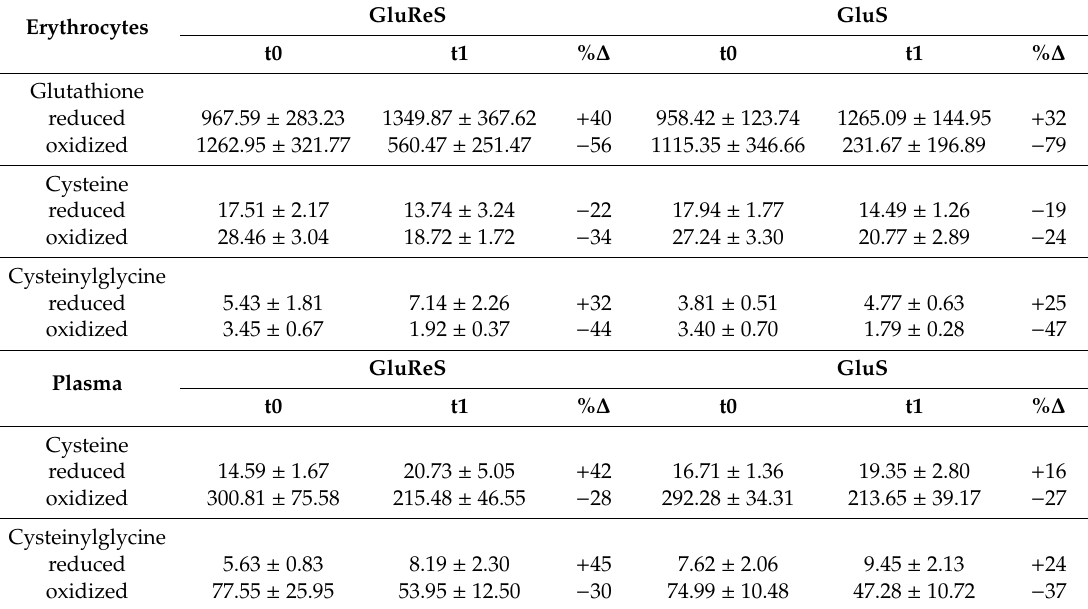
Table 3. Before and after concentrations ( µ M) of reduced and oxidized forms of glutathione, cysteine and cysteinylglycine in erythrocytes and plasma for the two groups.